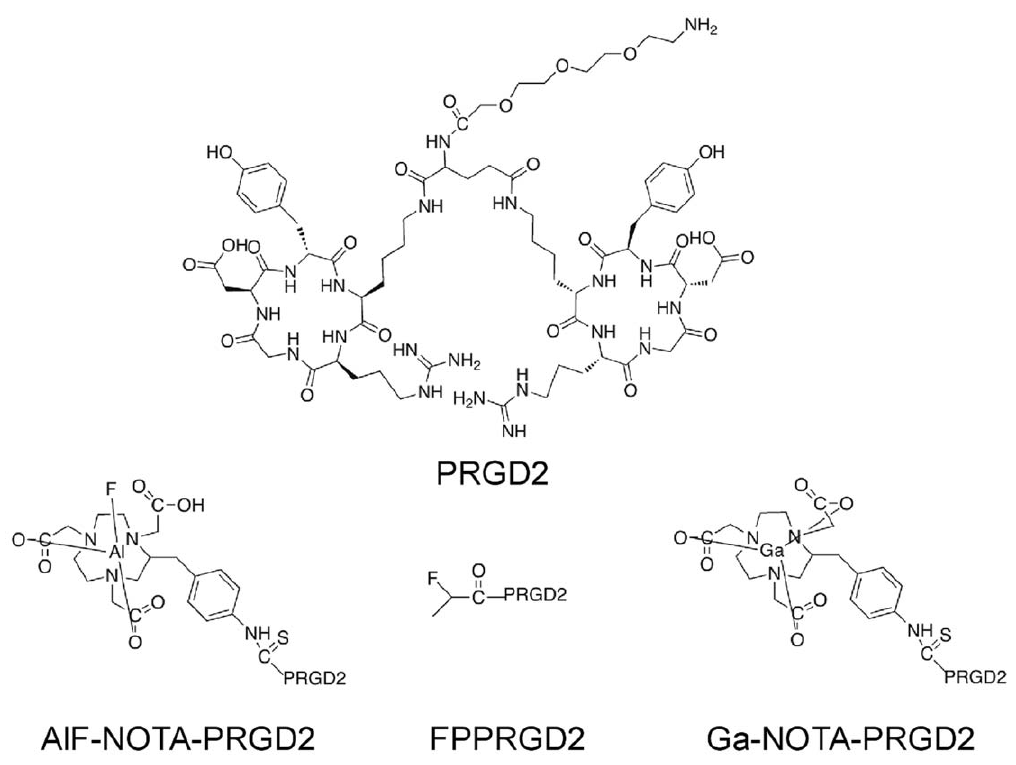
Figure 1. Chemical structures of three dimeric RGD peptides [ 18 F]FPPRGD2, [ 68 Ga]Ga-NOTA-PRGD2 and [ 18 F]AlF-NOTA-PRGD2.